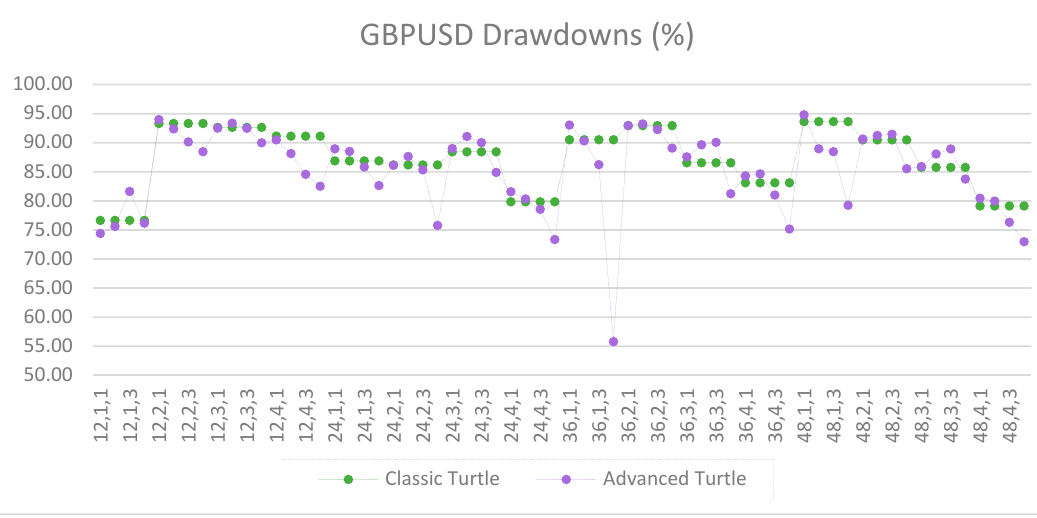
Figure A22. Drawdowns of GBPUSD as percentage of equity between the classic and the advanced Turtle systems for every combination of N, X, Y for the medium parameters (40, 80).